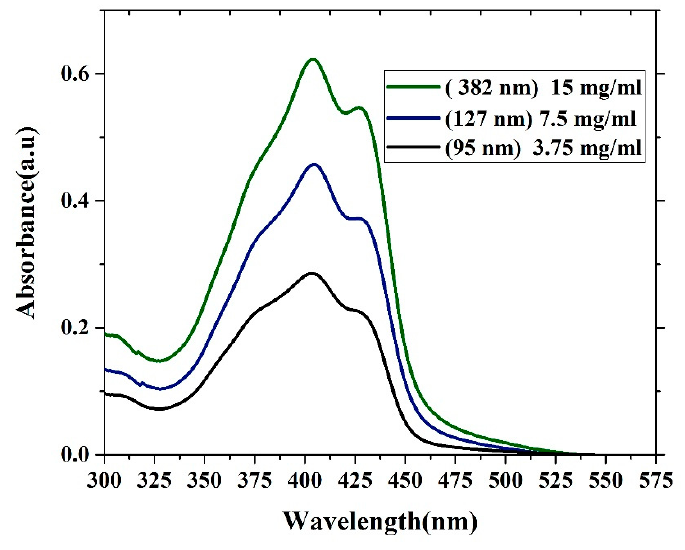
Figure 6. Absorption spectra of the CO BEVC-DHF samples with different thicknesses (380 nm, 127 nm, and 95 nm). Table 1. The absorbance ratio of the different peaks of the CO films .